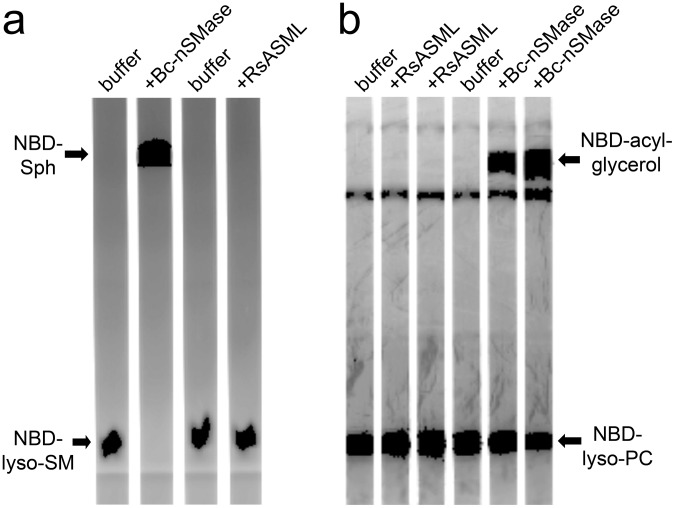
Phospholipase activity of RsASML and Bc-nSMase towards NBD-lyso-SM and NBD-lyso-PC.(a) Fluorescently imaged TLC plate of NBD-lyso-SM reactions. (b) Fluorescently imaged TLC plate of NBD-lyso-PC reactions. RsASML reaction conditions: 10 mM HEPES, pH 8.0, 1 mM NiCl2. Bc-nSMase (Bacillus cereus nSMase) reactions conditions: 10 mM HEPES, pH 7.5, 10 mM MgCl2.